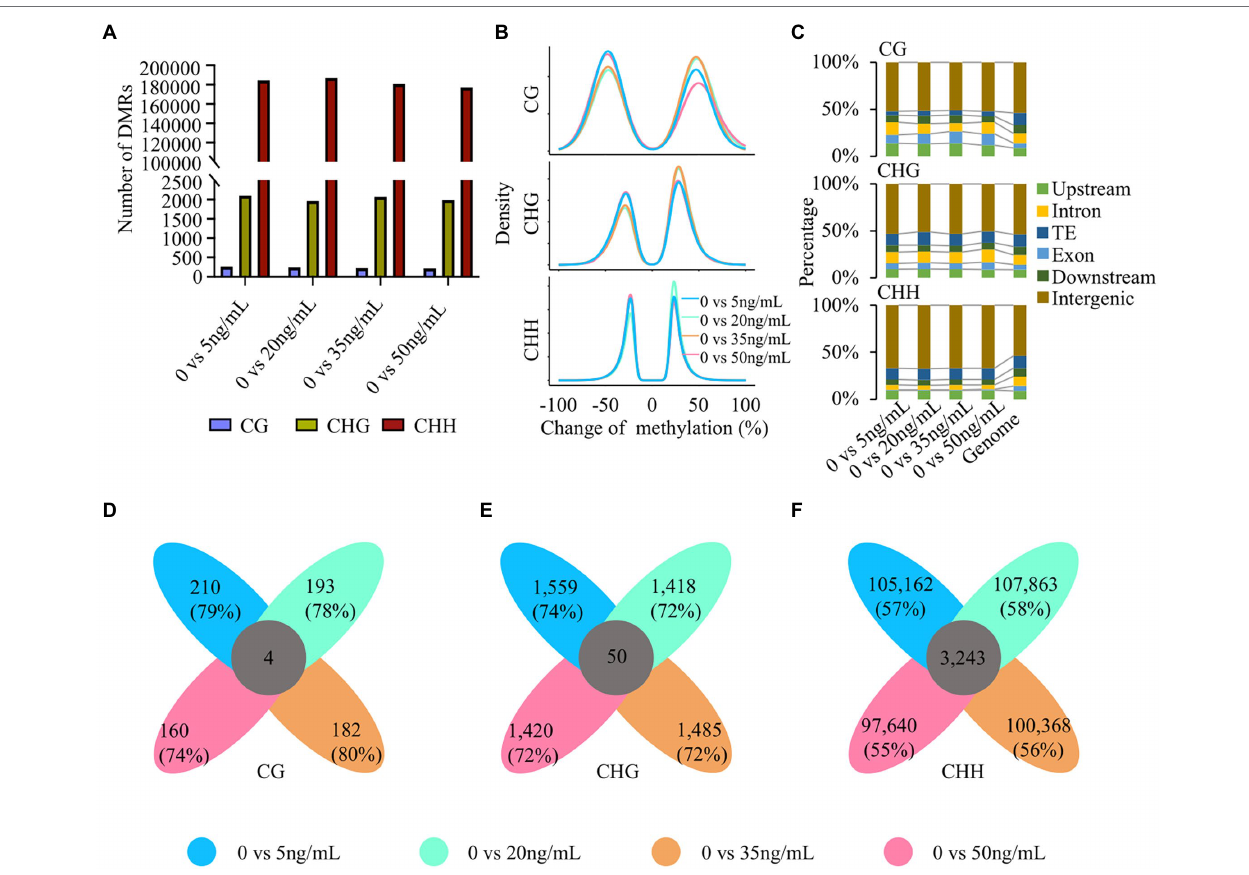
FIGURE 3 | Differential methylation regions (DMRs) after treatment with different DON concentrations. (A) The number of DMRs at five DON concentrations. Zero nanogram per milliliter was taken as a reference to assess DNA methylation changes. (B) The density of differential methylation regions of CG, CHG, and CHH contexts. (C) Overlapped genomic features of DMRs. Genome was divided into upstream, exon, intron, TEs, downstream, and intergenic regions. (D–F) Venn diagram shows the number of concentration-specific and common DMRs of three